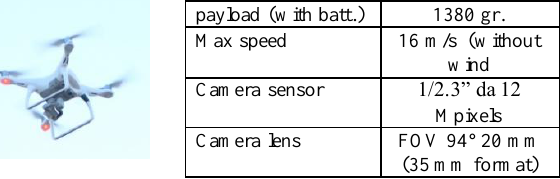
Figure 3. An image and some specs of the commercial low .cost solution: DJI phantom 4.